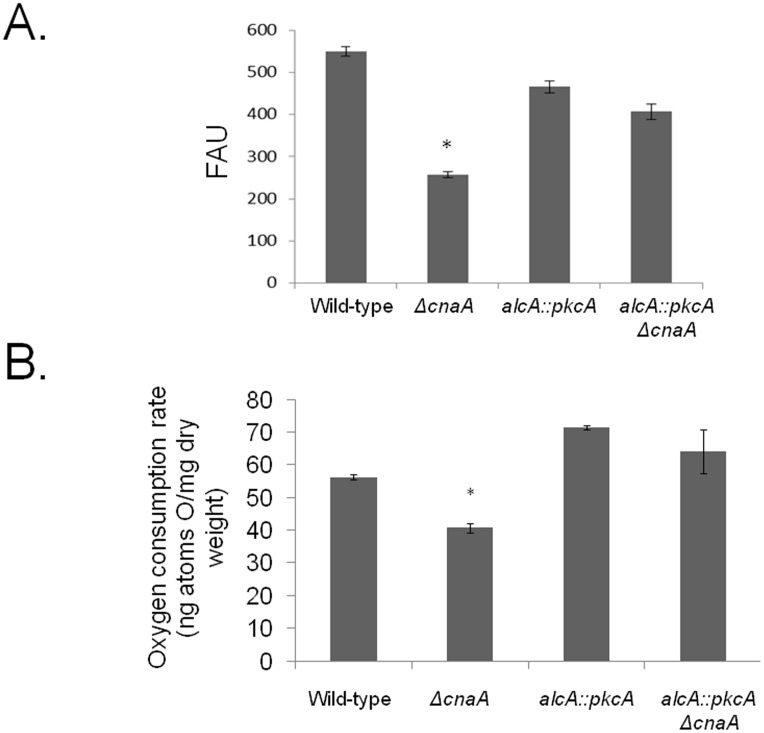
Overexpression of pkcA in a ΔcnaA background restores oxygen consumption.(A) Wild-type, ΔcnaA, alcA::pkcA and alcA::pkcA ΔcnaA germlings were grown in minimal medium supplemented with 2% glycerol plus 100 mM threonine for 16 hours at 37 C and stained with nonyl acridine orange for 10 minutes at 37°C. Mycelial fluorescence was subsequently assessed under the microscope (scale bars indicate 5 µm). Flow cytometric analyses (FCA) is shown. The results are expressed as mean ± SD (standard deviation) of three independent biological replicates and were considered statistically different (*) when p<0.05. P-values were determined by a Student t test using GraphPad Prism software version 5 (GraphPad Software). DIC, differential interference contrast; FAU, fluorescent arbitrary units. (B) Oxygen consumption rates of the wild-type, ΔcnaA, alcA::pkcA and alcA::pkcA ΔcnaA strains when grown in minimal medium supplemented with 2% glycerol plus 100 mM threonine for 16 hours at 37°C.